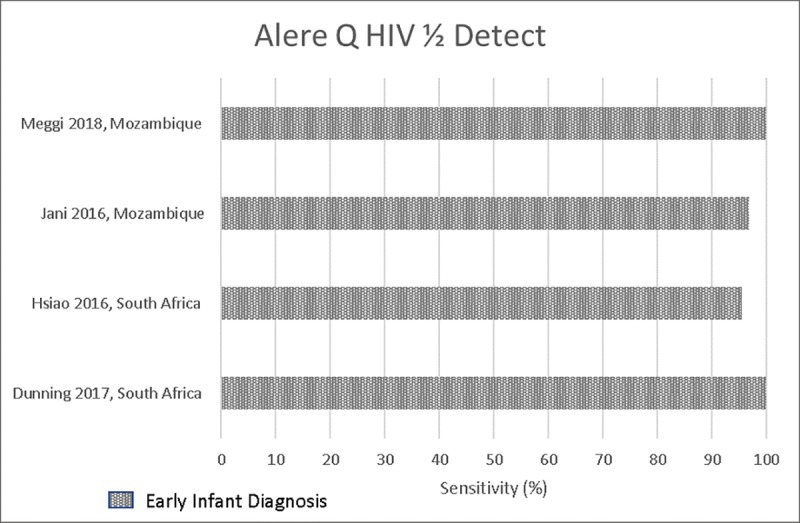
Alere Q HIV½ Detect (Qual) for Early Infant Diagnosis.